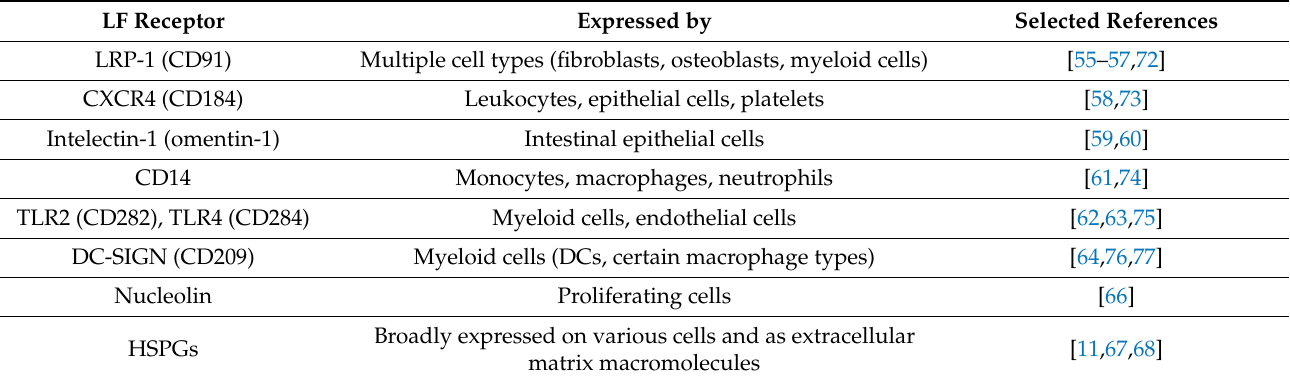
Table 1. Cell surface receptors of LF and cell types in which they are